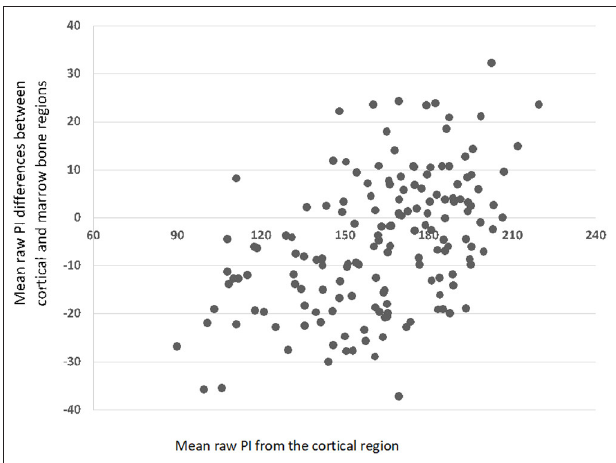
FIGURE 3 | Scatterplot with mean pixel intensity (PI) differences between the cortical and marrow bone regions ( N = 160).